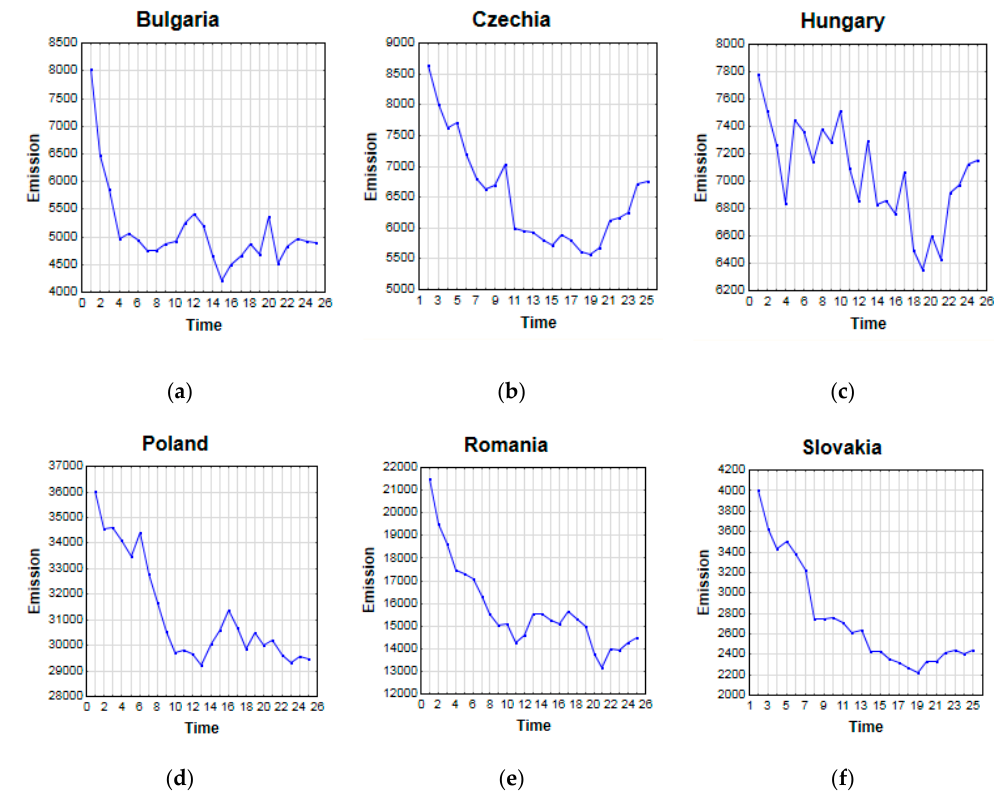
Figure 1. CO 2 emissions in agriculture in the countries of Central and Eastern Europe in 1992–2016: Bulgaria ( a ), Czechia ( b ), Hungary ( c ), Poland ( d ), Romania ( e ) and Slovakia ( f ). The variables on the x -axis represent the years of analysis (1992(0)–2016(26)). Source: own study according to FAOstat